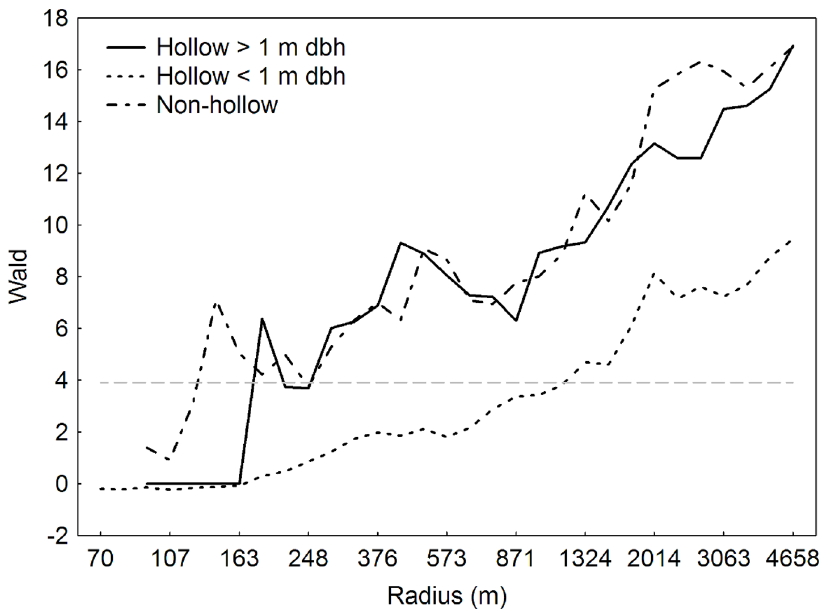
Figure 2. The relationships between occurrence of Elaterferrugineus and density of trees in different hollow classes. The relationships are expressed as Wald-values from 63 simple binomial GLMs. The explanatory variable ‘tree density’ is measured at 31 different spatial scales and includs trees from three different tree hollow classes: hollow trees $ 1 m dbh, hollow trees , 1 m dbh and non-hollow trees. All models showed positive relationship between probability of occurrence and tree density. The grey line indicates p , 0.05, corresponding to Wald value 3.9. doi:10.1371/journal.pone.0066149.g002 (Figure 6e, 6f). The ROC curves showed that large-scale models performed better, when applied to the validation data sets, than the small-scale models (Figure 7). In fact, small-scale models, especially when applied to the strategically sampled data set, did